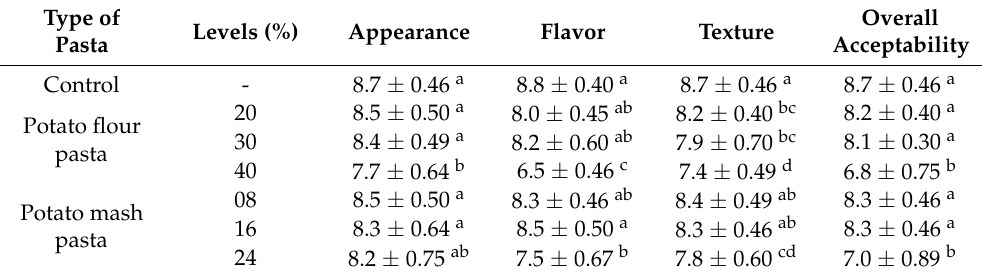
Table 7. Effect of replacing potato powder and mash with semolina on the sensory characteristics * of